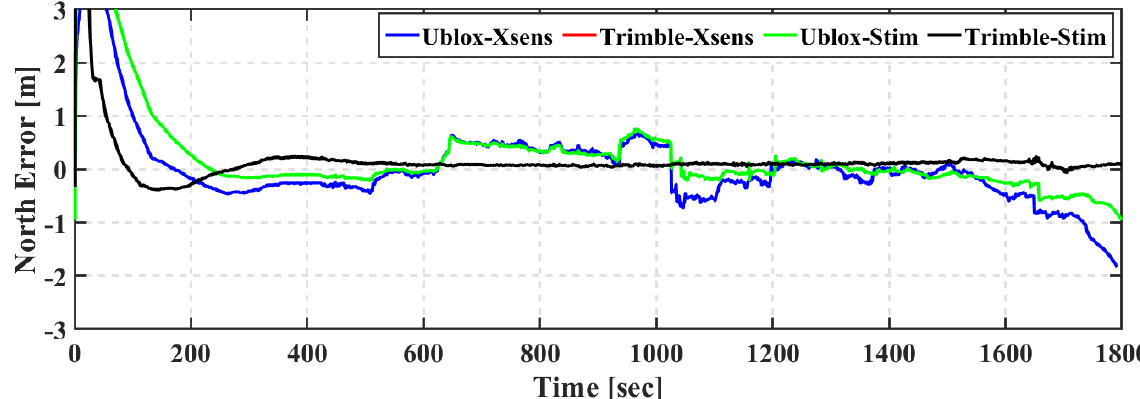
Figure 6. First field trial: North positioning error of real-time TC GNSS PPP/INS for Ublox–Xsens, Trimble–Xsens, Ublox–Stim, and Trimble–Stim solutions.